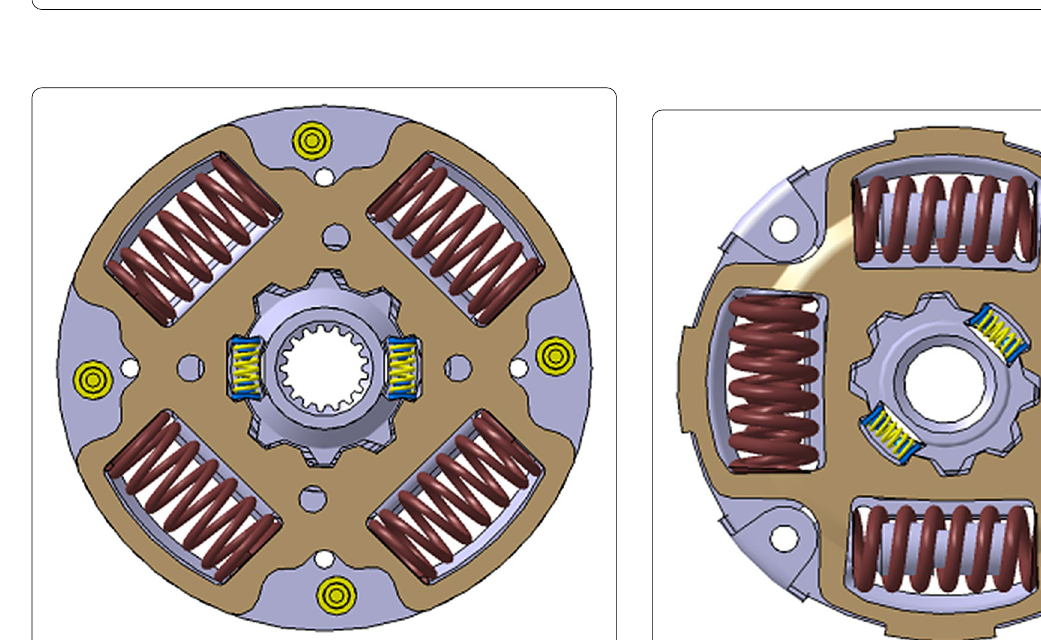
Figure 4 Diagram of clutch-driven disc assembly for wide-angle, large-hysteresis, multistage damper. 1. Main damping spring (outer), 2. Rubber cushioning spring, 3. Main damping spring (inner), 4. Friction facing rivet, 5. Retain plate rivet, 6. Rear retain plate, 7. Friction facing, 8. Cushion plate, 9. Front retain plate, 10. Pre-damping Belleville washer, 11. Pre-damping hysteresis plate, 12. Main damping Belleville washer, 13. Main damping plate, 14. Hub plate, 15. Hub 16. Pre-damping hub plate, 17. Primary pre-damping spring, 18. Cushioning rubber pad, 19. Secondary pre-damping spring, 20. Rear hysteresis plate